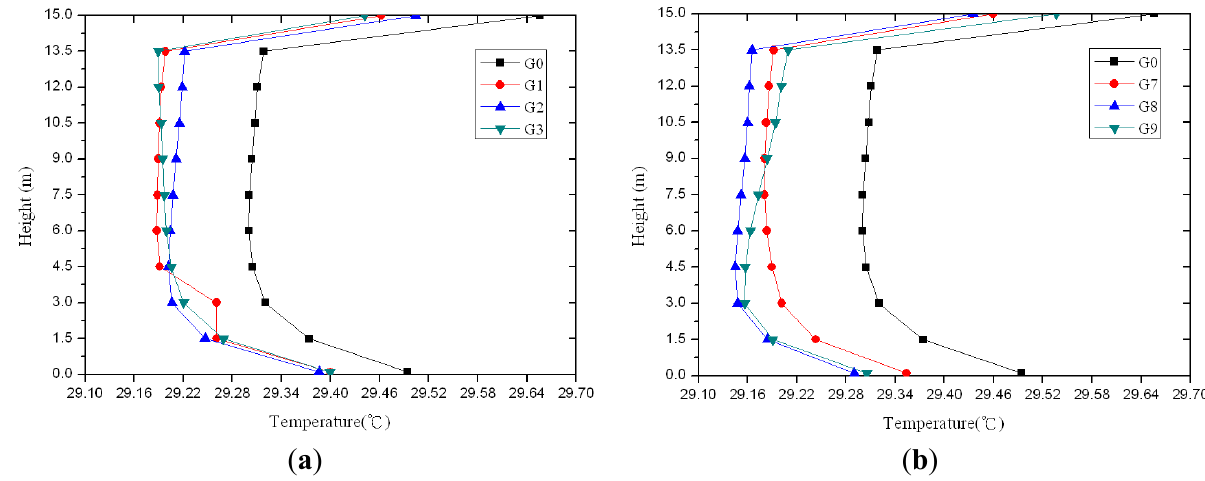
Figure 7. Simulated temperatures in different heights: ( a ) G0 and G1–G3; ( b ) G0 and